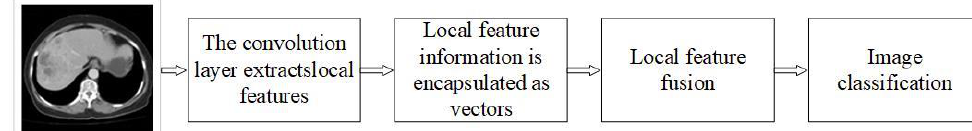
Figure 4. Image recognition process of liver cancer by CapsNet.